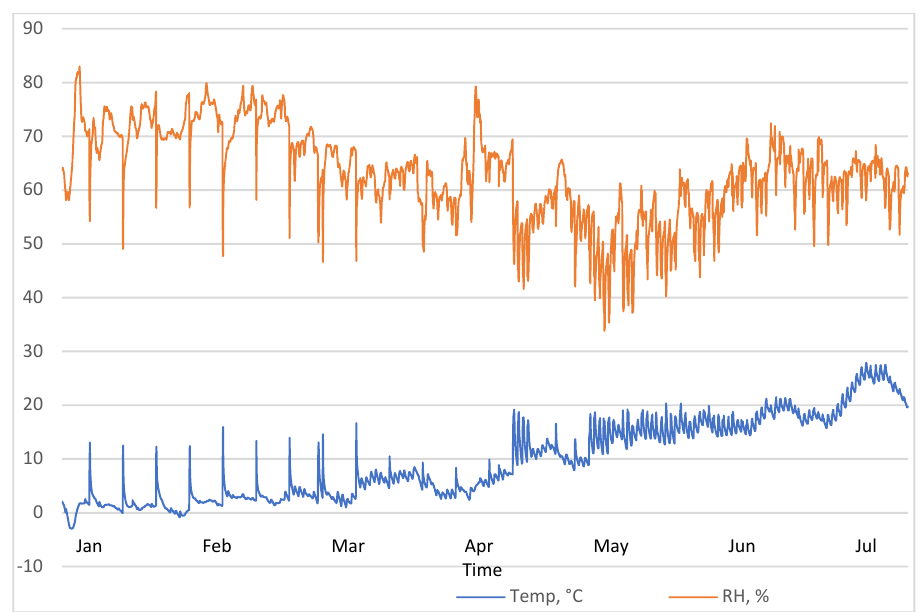
Figure 8. Humidity and temperature measurements in Turaida church.